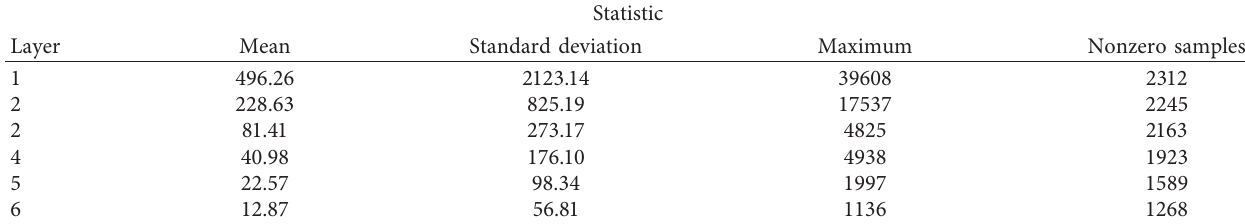
Table 1: Statistics of the number of nodes in each layer in the rumor propagation cycle.